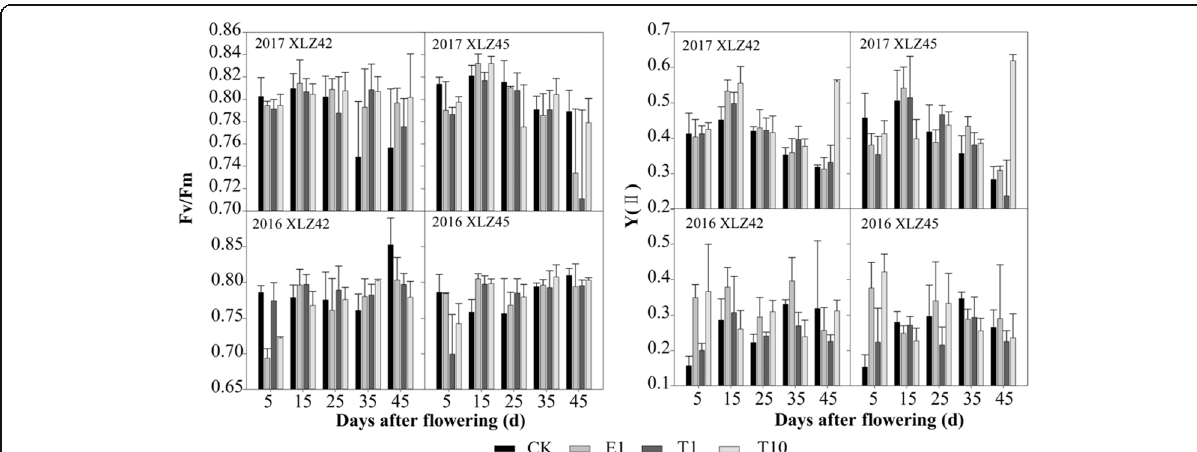
Fig. 5 Maximum photochemical quantum yield of PS-II (Fv/Fm) and actual photochemical quantum yield of PS-II (Y (II)) of cotton varieties (XLZ42 and XLZ45) at different days since flowering in various treatment groups: 1 and 10 days before the first irrigation (T1, T10, respectively) and 1 day before the second irrigation (E1) after seedling emergence, during 2016 – 2017. The control group (CK) had film mulching throughout the growth stages. Bars are means ± standard deviation (n = 3)